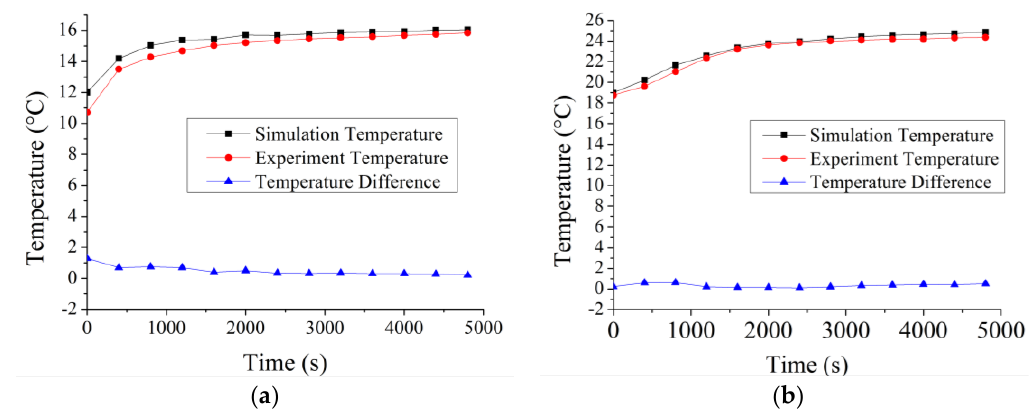
Figure 11. The difference between the predicted and measured temperatures at the water outlet. ( a ) Spindle speed at 10,000 rpm, ( b ) Spindle speed at 15,000 rpm.